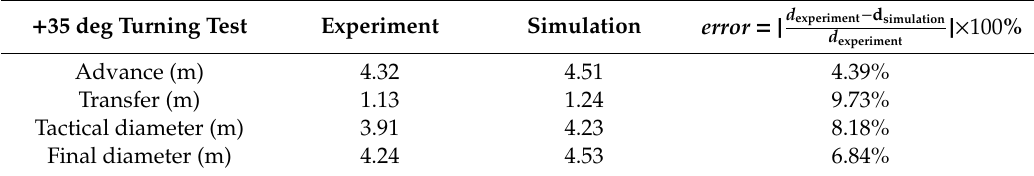
Table 3. Compare for results of the +35 deg turning test.